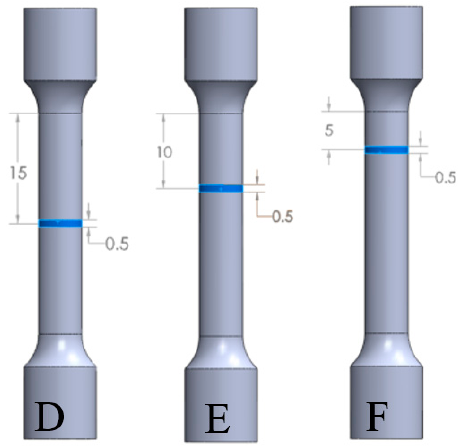
Figure 9. Designed failure locations for customised specimen set.